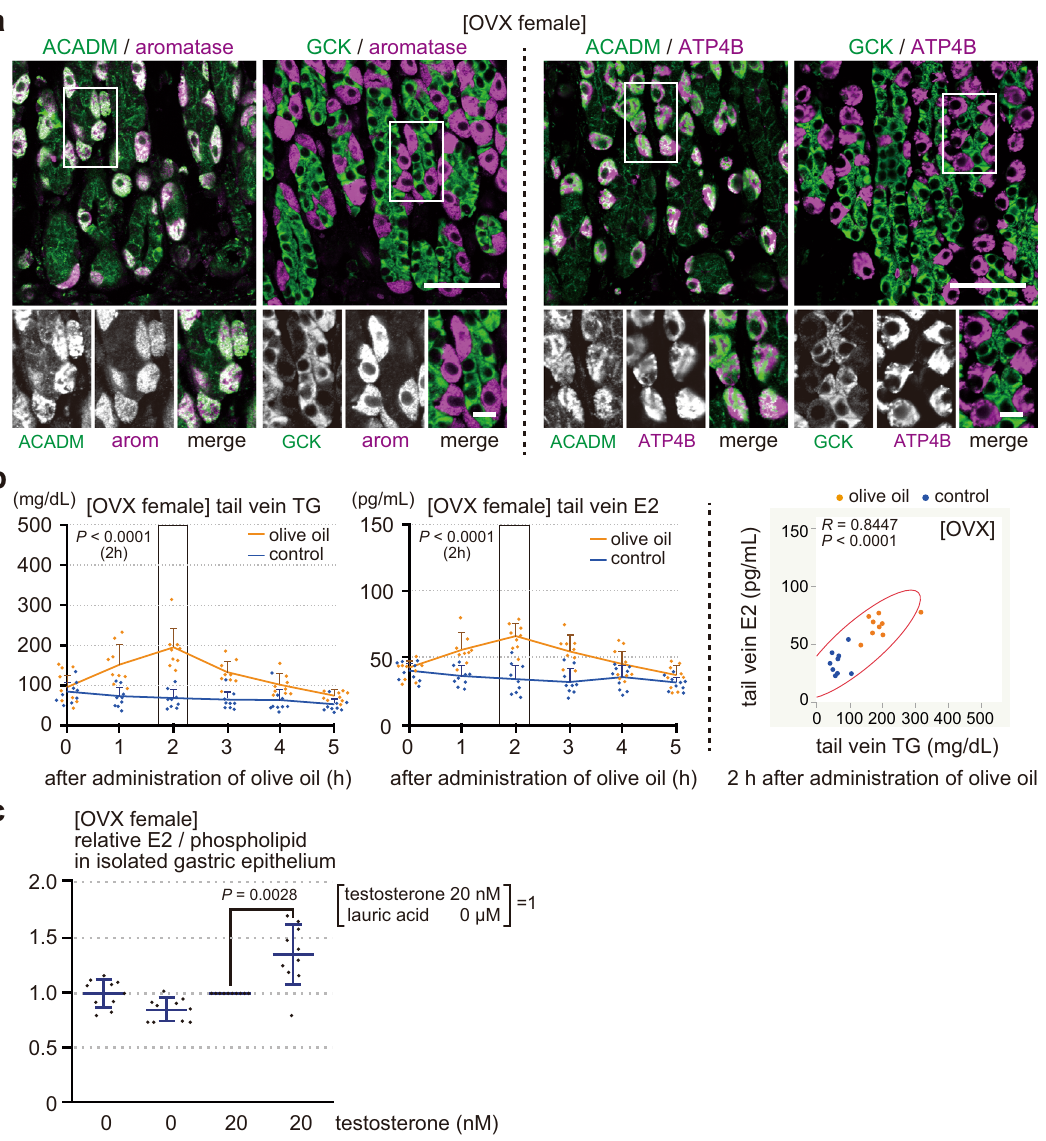
Fig. 5 Stomach of OVX female rats, like of male rats, secretes estrogen in response to the blood triglyceride levels. a Gastric mucosa from an OVX female rat (8 weeks old, operated 14 days before) was double-stained for ACADM or GCK (green) with aromatase [arom] or ATP4B (magenta). b OVX female rats, deprived of food for 4 h, were orally administered olive oil (2.5 mL per kg body weight, n = 9) or control water ( n = 9). TG and E2 levels in the tail venous blood measured before (0) and at 1, 2, 3, 4, and 5 h after the administration (left), and the correlation diagram between the blood TG and E2 levels at 2 h after the administration ( n = 18, right). c Isolated epithelium from OVX female rat (deprived of food for 4 h) was incubated in DMEM with or without testosterone (20 nM) or lauric acid (500 µ M) at 37 °C for 1 h. E2 levels, normalized by phospholipid, were compared to those incubated with 20 nM testosterone but without lauric acid ( n = 10). n number of rats. Data were mean ± s.d. b left (2 h) and c P values determined by two-sided Student ’ s t -test. b right, R and P values determined by Pearson ’ s product-moment correlation with 95% density ellipse. Bars: (main panels) 50 µ m; (insets) 10 µ